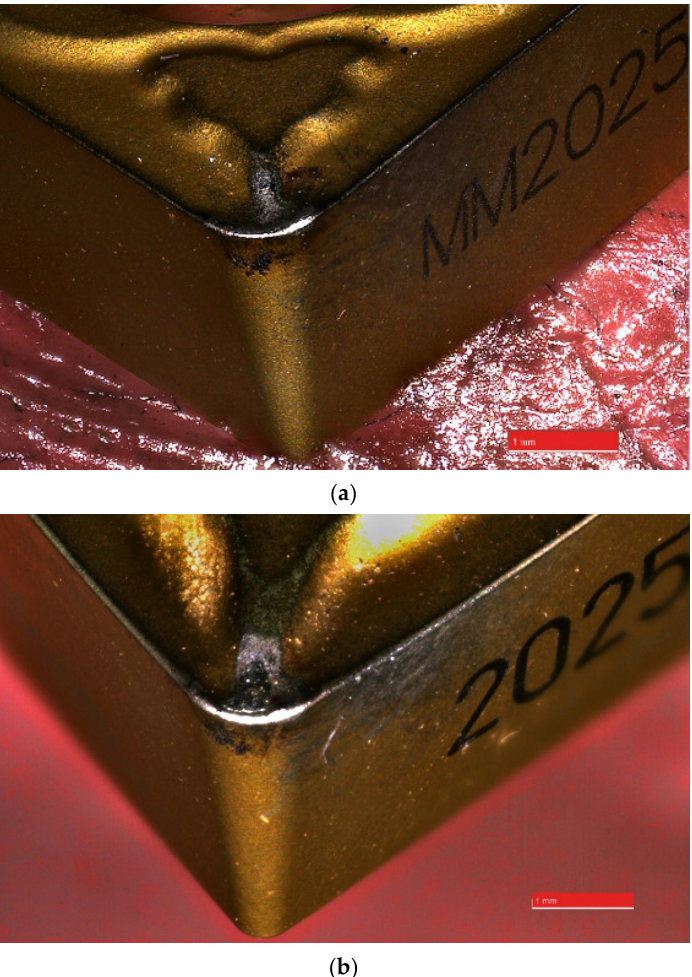
Figure 5. The view of inserts type ( a ) CCMT09T308-MM (CC1); ( b ) CCMT09T308-UM (CC2) after machining with DSS samples.